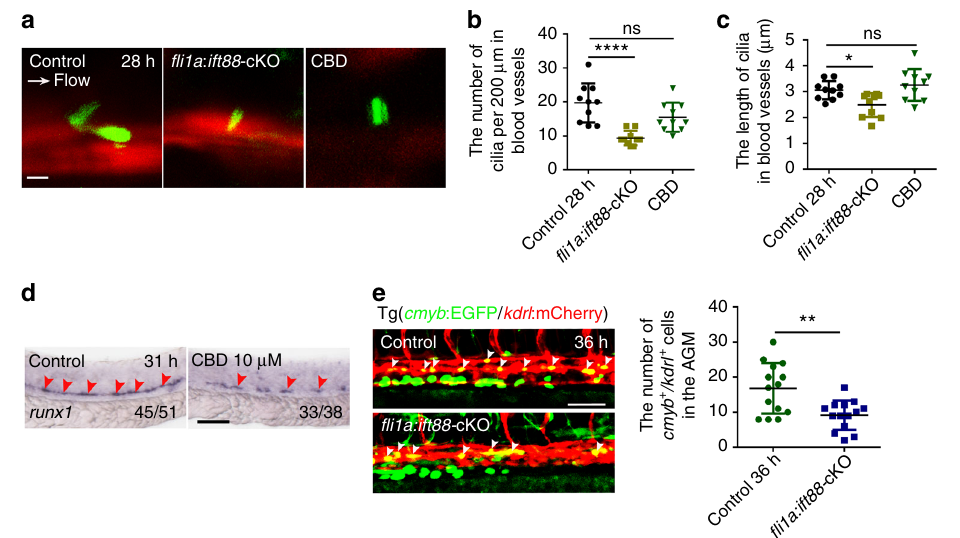
Fig. 4 Blocking formation or function of primary cilia impairs hematopoietic stem and progenitor cell (HSPC) development. a Confocal imaging of cilia in the aorta-gonad-mesonephros (AGM) region in kdrl :mCherry/ β act:Arl13b – GFP double-transgenic line with fl i1a : ift88 -cKO-functional injection, or ciliobrevin D (CBD) treatment at 28 hpf. White arrow denotes the blood fl ow direction. Scale bar, 5 µ m. b , c The quanti fi cation of primary cilia number and length in the blood vessels of AGM in a . Data in b , c represent the analysis results of one-way ANOVA – Dunnett test. Error bars, mean ± s.d., n = 10 embryos. ns non- signi fi cant, * P < 0.05, **** P < 0.0001. d WISH result of runx1 (red arrowheads) in control and CBD-treated embryos at 31 hpf. The red arrowheads indicate the expression of HSPC marker runx1 . Scale bar, 100 µ m. e The kdrl :mCherry + / cmyb :EGFP + HE cells (white arrowheads) in the AGM region in fl i1a : ift88 - cKO-injected embryos (left panel) with quanti fi cation (right panel) at 36 hpf. Cmlc2:EGFP-negative embryos were used as a negative control (control). Scale bar, 50 µ m. Error bars, mean ± s.d., n = 14 embryos. ** P < 0.01, Student ’ s t